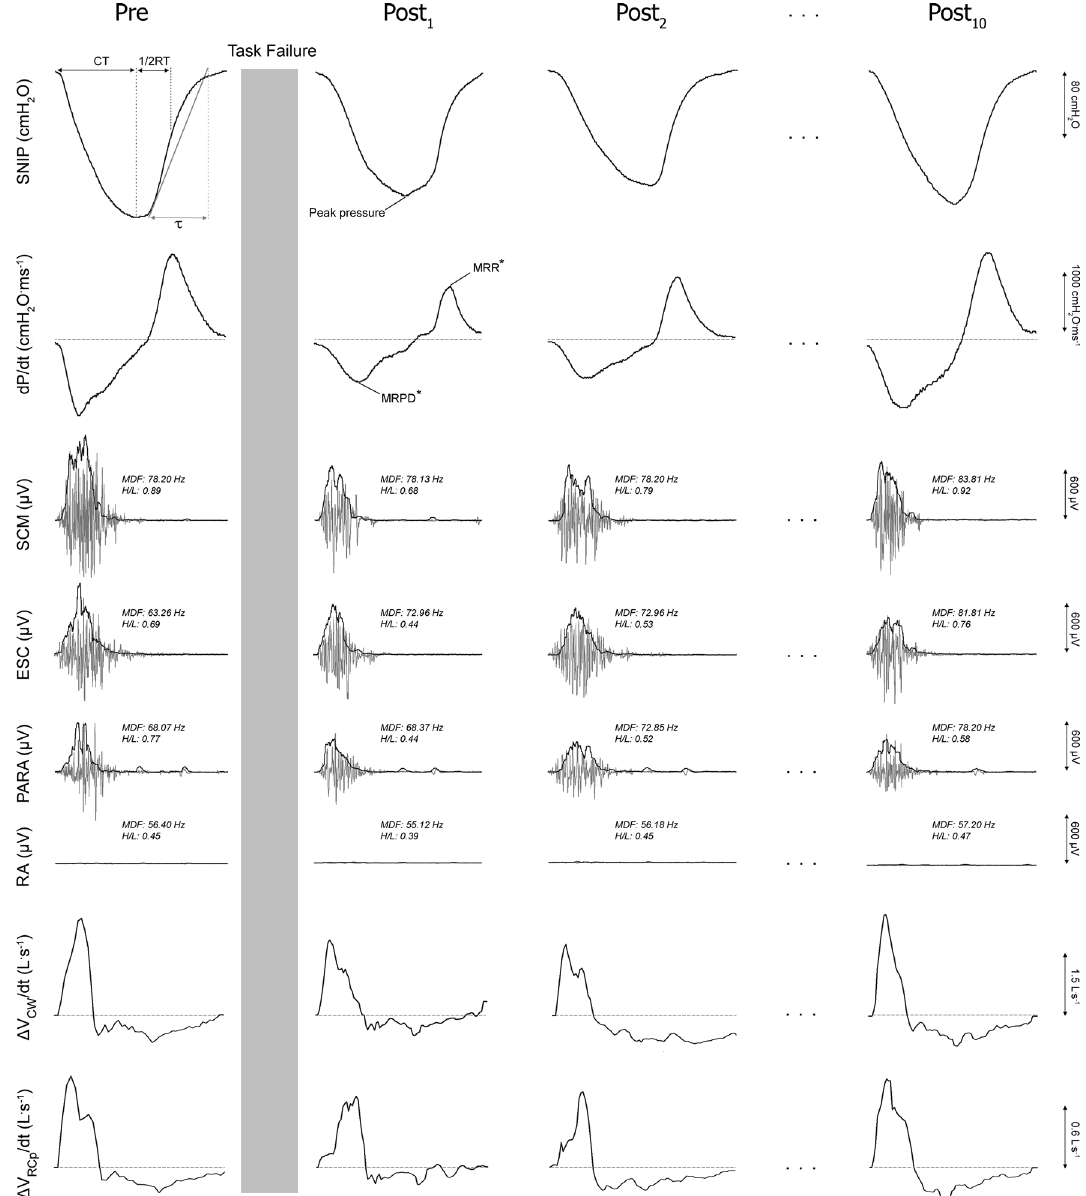
Figure 1. Representative tracings of the sniff pressure curve and its derivative (dP/dt), surface electromyography of sternocleidomastoid (SCM), scalene (ESC), parasternal (PARA) and rectus abdominis (RA) muscles, and shortening velocity index of the global (ΔV CW /dt) and ribcage (ΔV RCp /dt) inspiratory muscles obtained in one subject before (Pre) and after (Post 1 , Post 2 … Post 10 – recovery) the fatigue protocol. Grey and black traces of the surface electromyography signal represent raw and root mean squared data, respectively. The calculation of the time constant of the relaxation curve (τ) is shown by drawing a tangent line at the initial rate of decay. Median frequency (MDF) and high/low frequency power (H/L) are also expressed. SNIP: sniff nasal inspiratory pressure; CT: contraction time; ½RT: half-time of relaxation curve; MRPD: maximum rate of pressure development; MRR: maximum relaxation rate; µV: microvolts; cmH 2 O: centimeters of water; L·s: liter per second. *MRPD and MRR are represented in the figure without normalization by peak